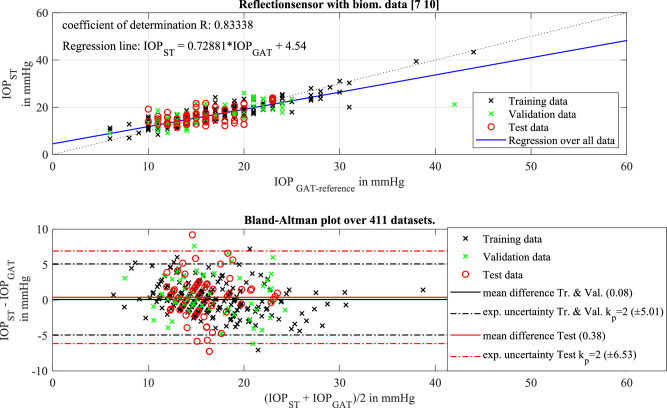
(Top) Regression plot of the ANN result. (Bottom) Bland–Altman plot of the self-tonometer results (ST) in reference to the GAT measurements. The achieved measurement uncertainty is calculated only from test data that was not used in the iterative ANN training and amounts to 6.53 mm Hg (kp = 2).